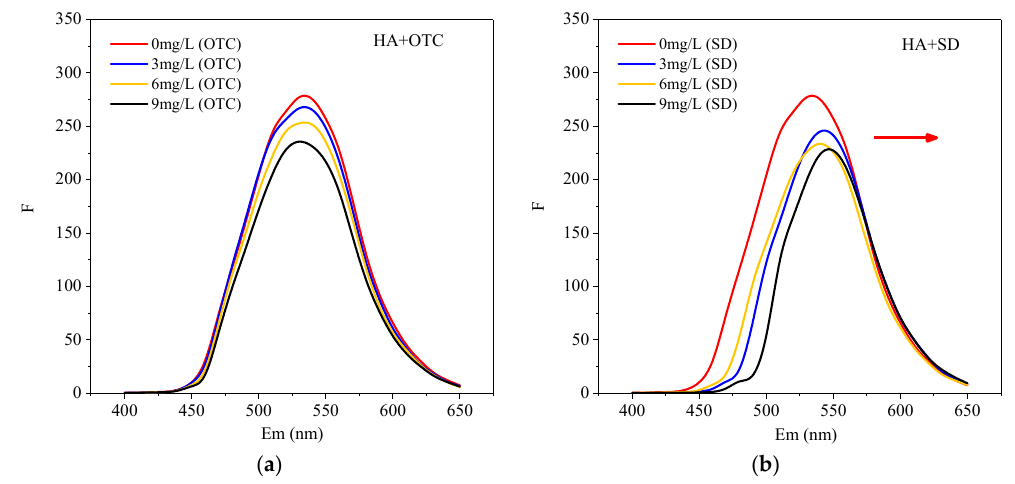
Figure 3. The fluorescence intensity (Ex/Em = 375nm/400–650nm) of HA with the presence of different concentration of ( a ) OTC and ( b ) SD.